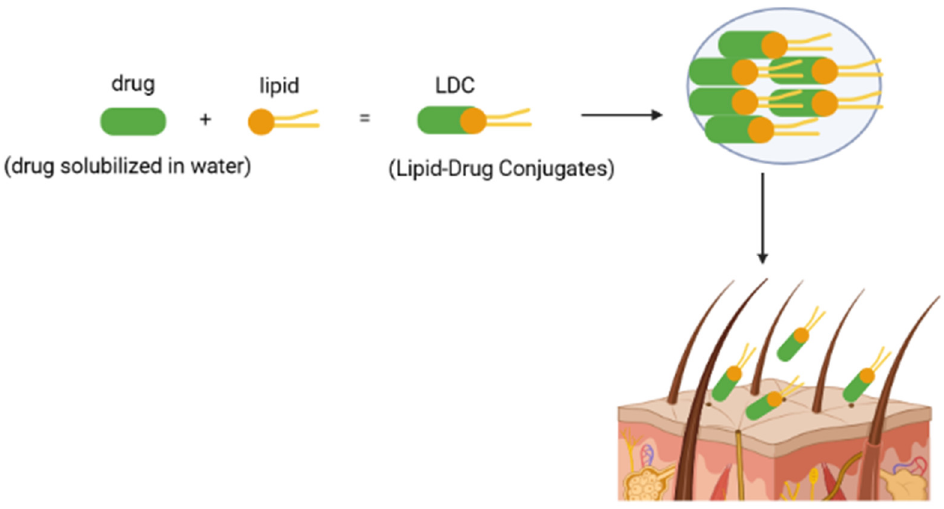
Figure 3. Schematic representation of the lipid-drug conjugates mechanism of action [own drawing].